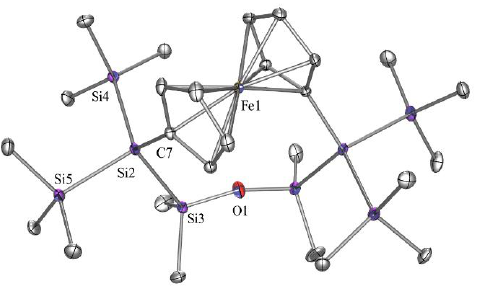
Figure 2. Molecular structure of compound 5 (thermal ellipsoid plot drawn at the 30% probability level). All hydrogen atoms are omitted for clarity (bond lengths in Å, angles in deg). Fe(1)-C(7) 2.080(3), O(1)-Si(3) 1.6250(11), Si(2)-C(7) 1.880(3), Si(2)-Si(3) 2.3474(12), Si(2)-Si(4) 2.3507(12), Si(2)-Si(5)